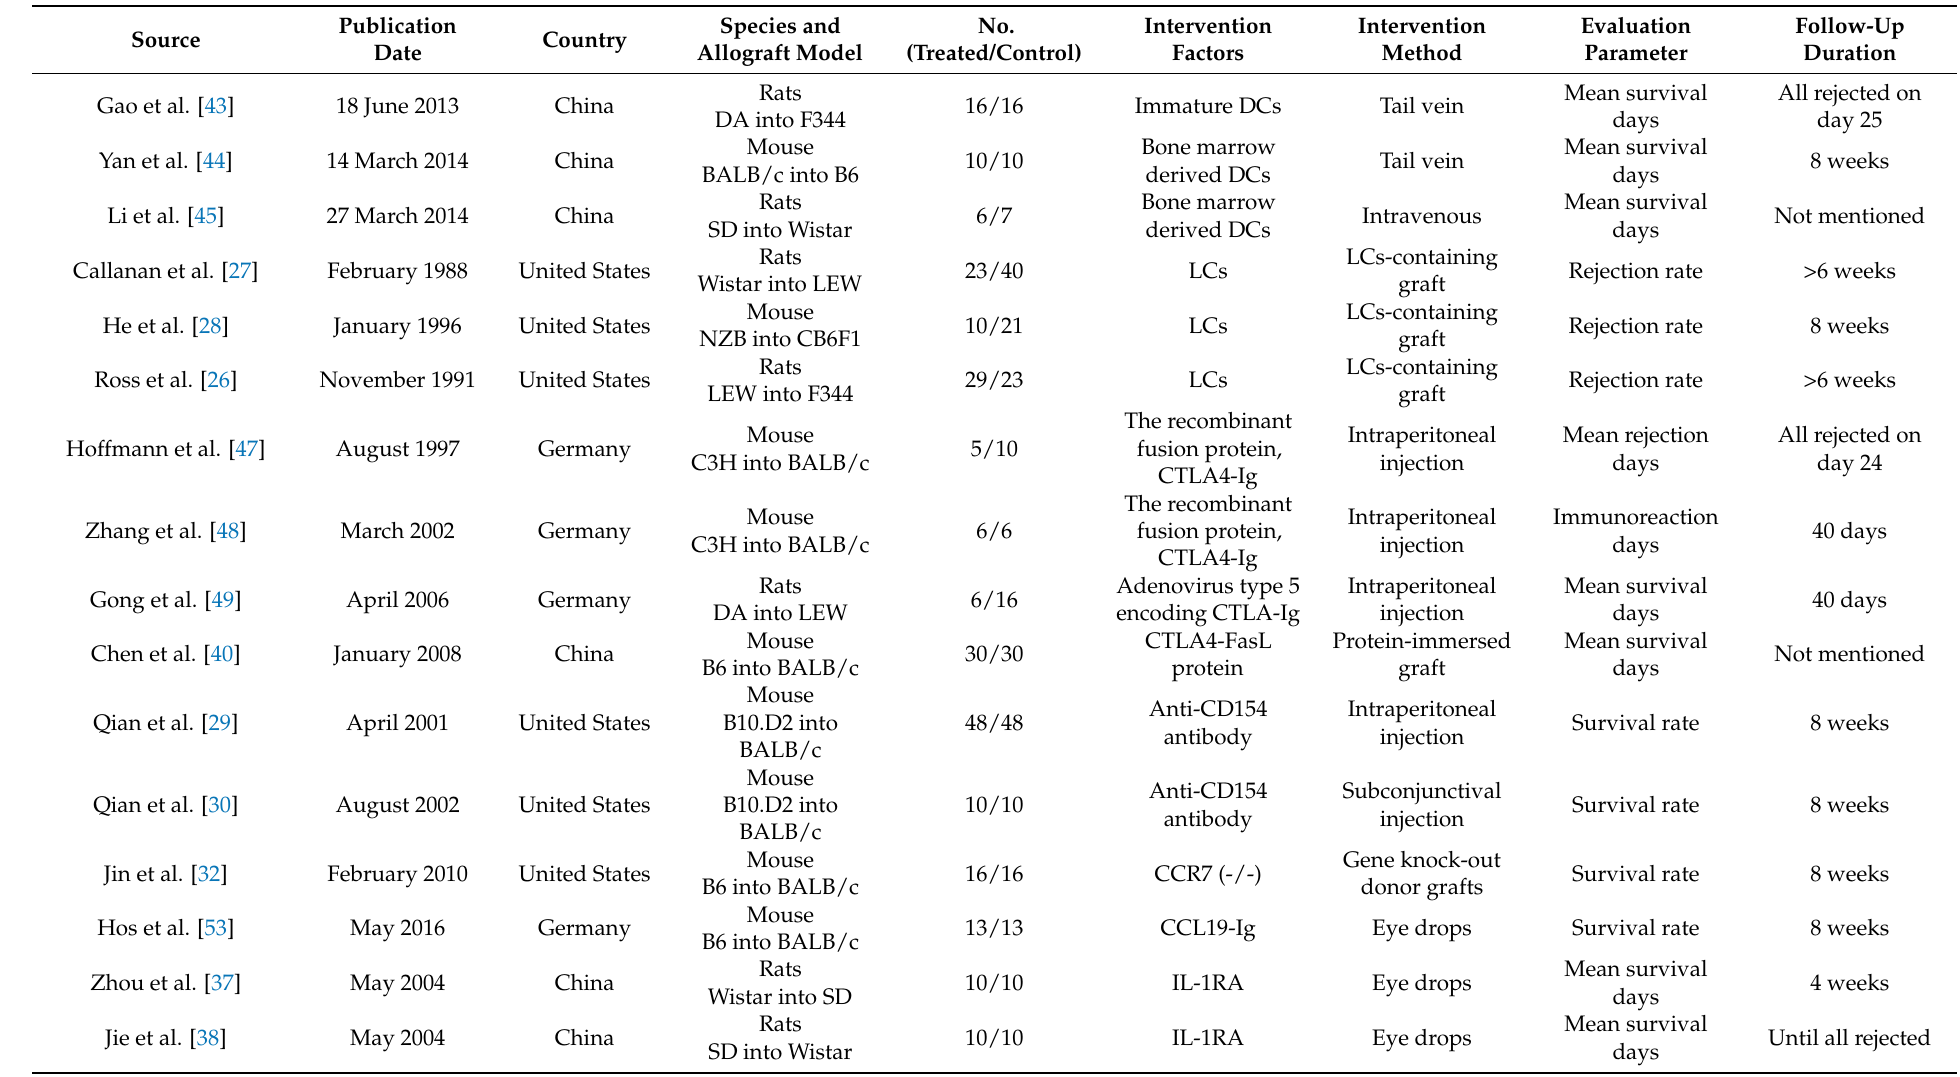
Table 2. Characteristics of studies included in the